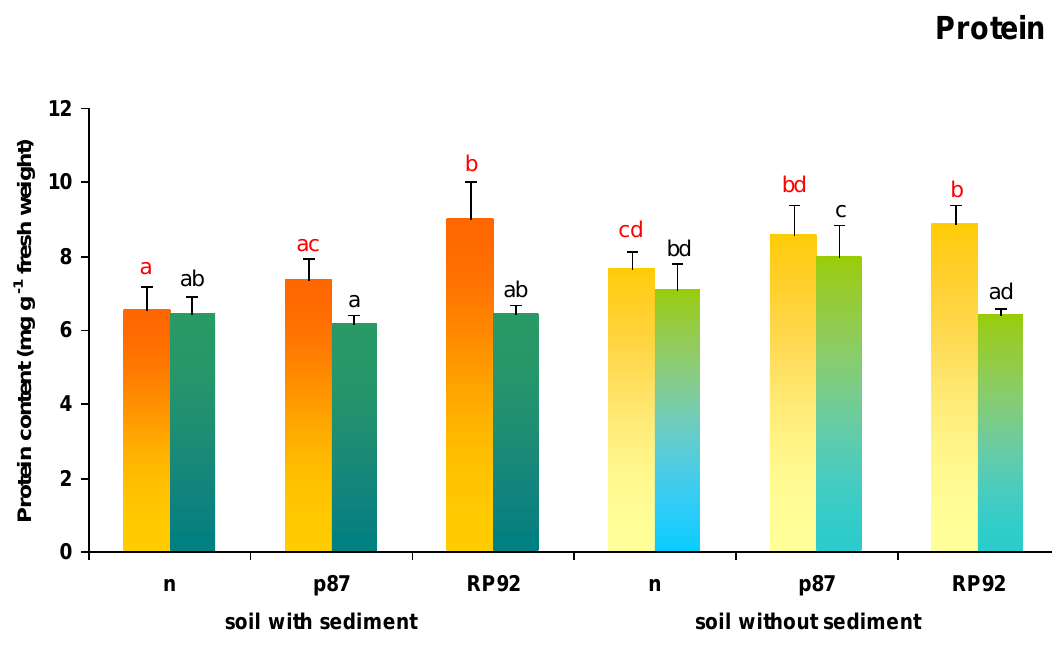
Figure 3. Soluble protein content in leaves of T. patula and F. arundinacea grown on control soil and soil amended with bottom sediments, with or without (n) inoculation with bacterial strain p87 or RP92. The same letters denote groups that did not significantly differ (at p < 0.05; the Duncan post hoc test). Statistical significance was measured for each plant separately and the results were marked by different colors.